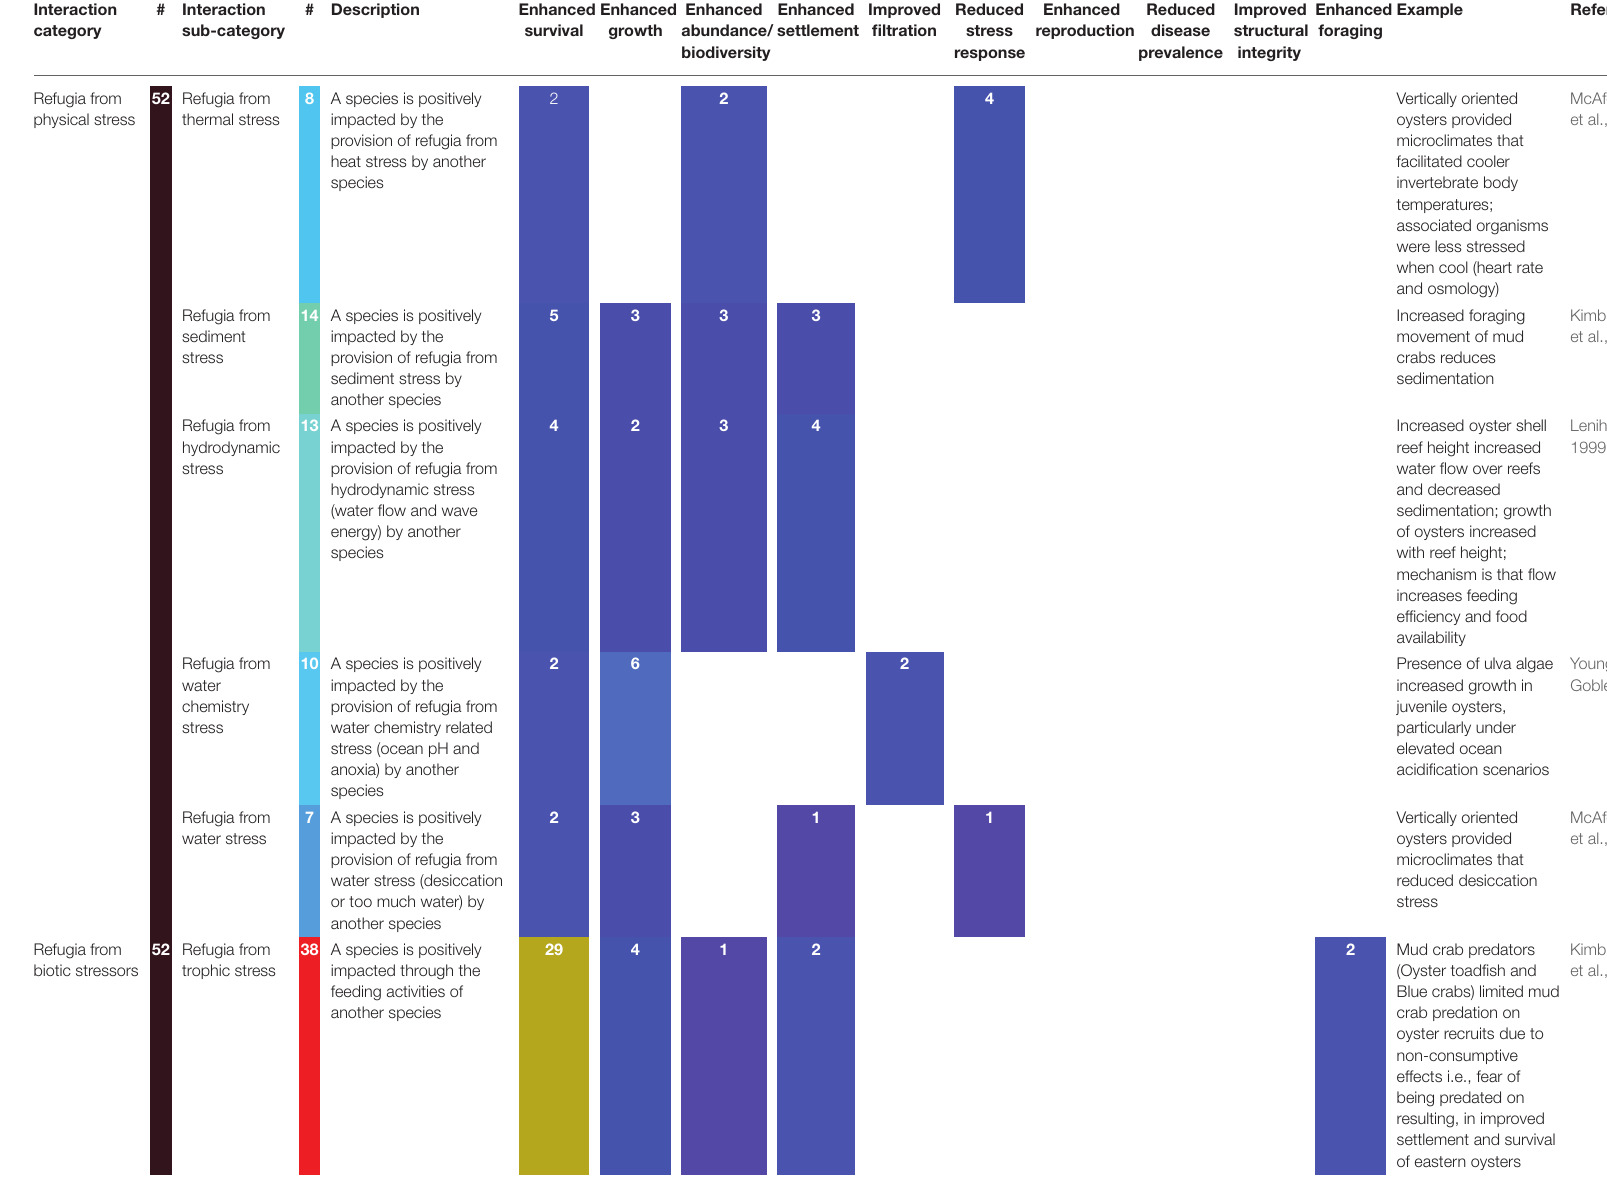
TABLE 1 | Descriptions of positive interaction mechanisms with outcomes and examples. Interaction